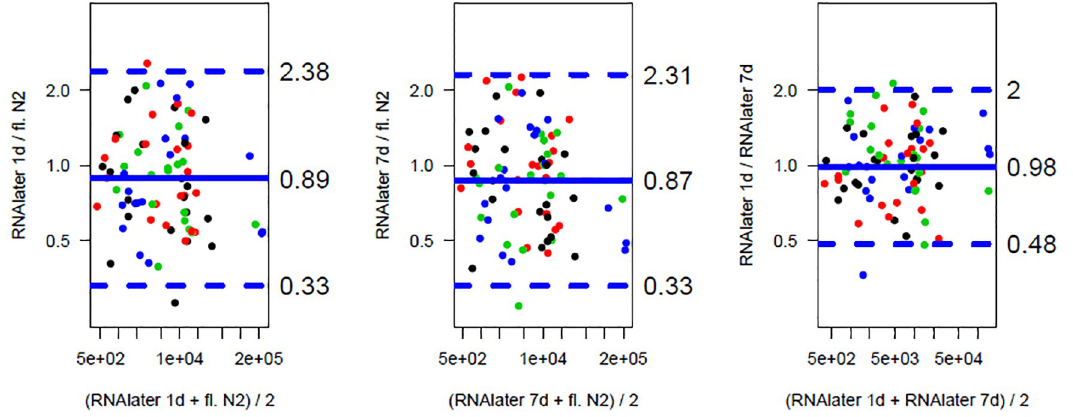
Fig 6. Conformance of RNA processing. Bland-Altman Plot demonstrating the conformance of RNA processing in RNAlater for 24 h or 7 days or snap freezing in liquid N2. The colours represent the different ischemic times (black 5’, red 20’, green 60’, blue